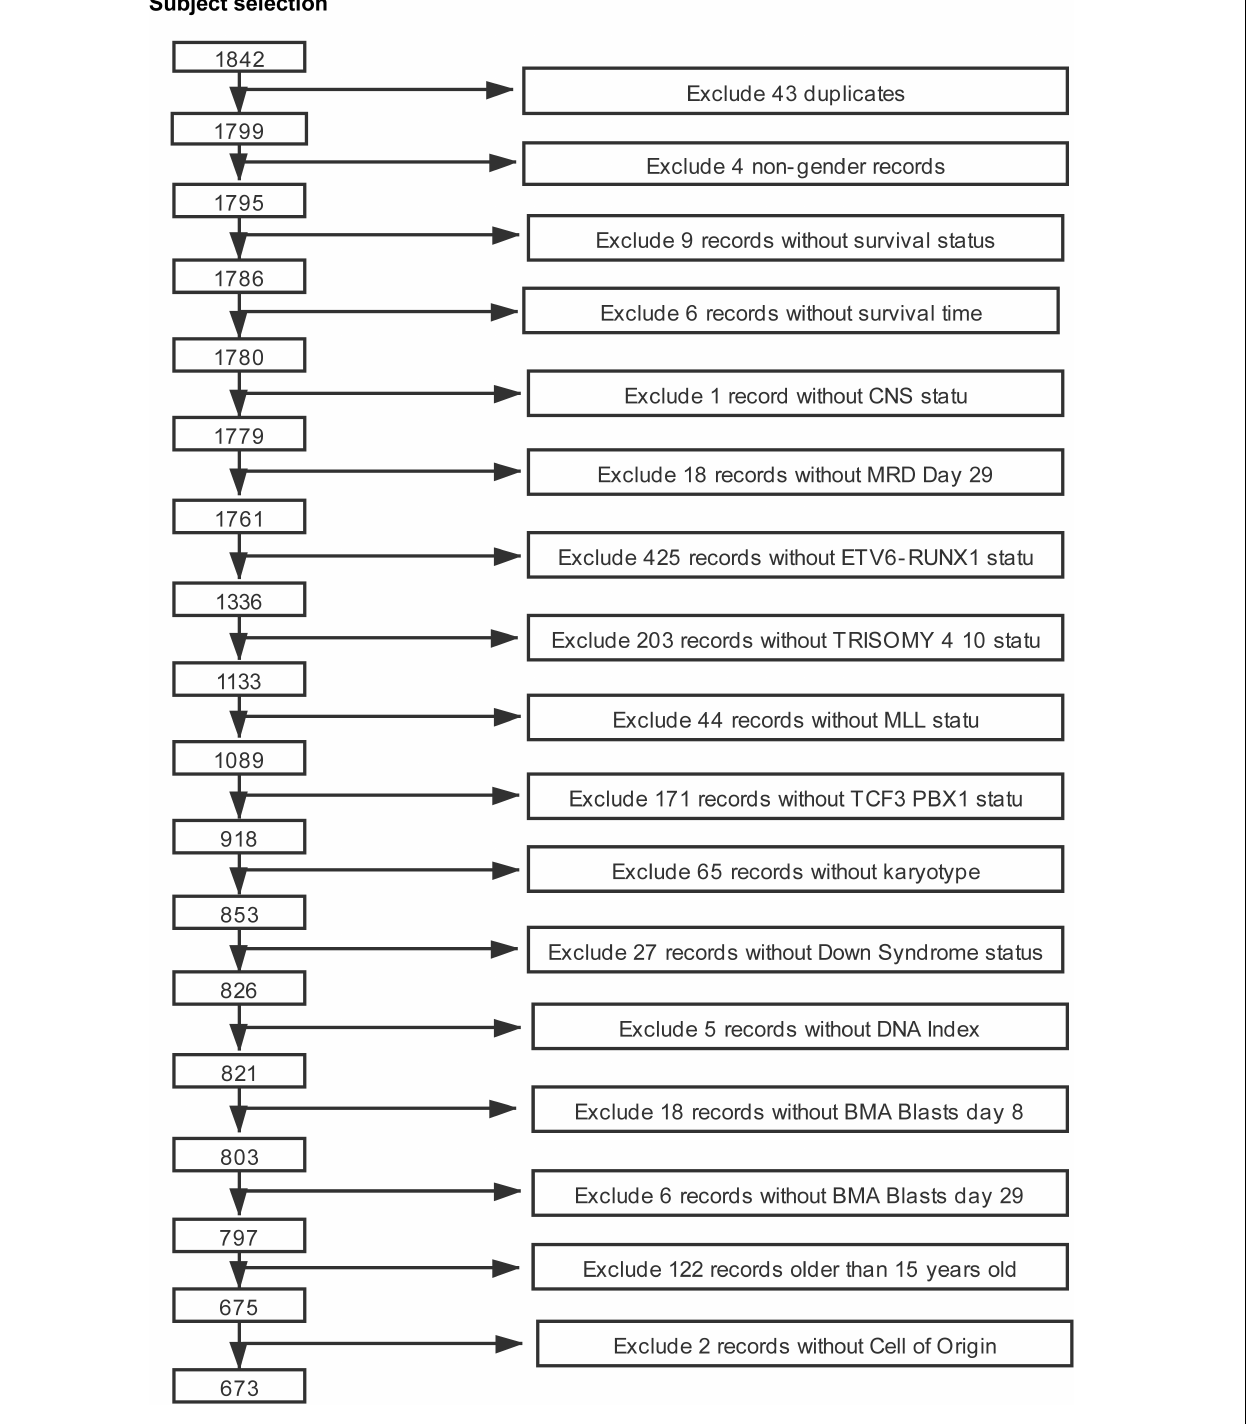
FIGURE 1 | The screening process for the study subject.